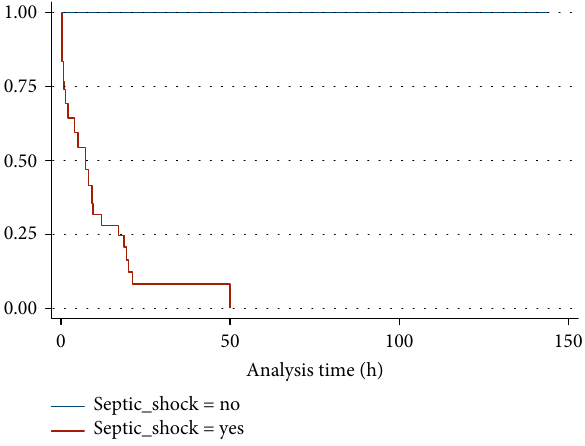
Figure 4: Kaplan–Meier survival curve showing estimate of death in hours in unit